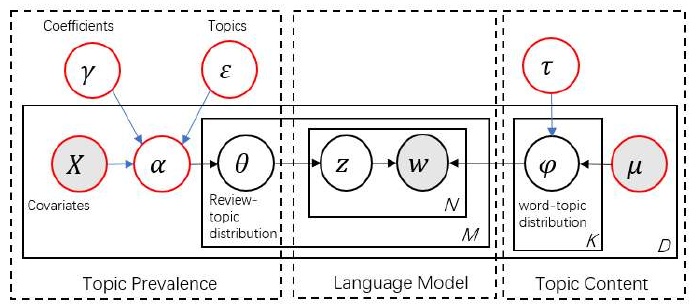
Figure 2. Plate diagram of structural topic model (STM).